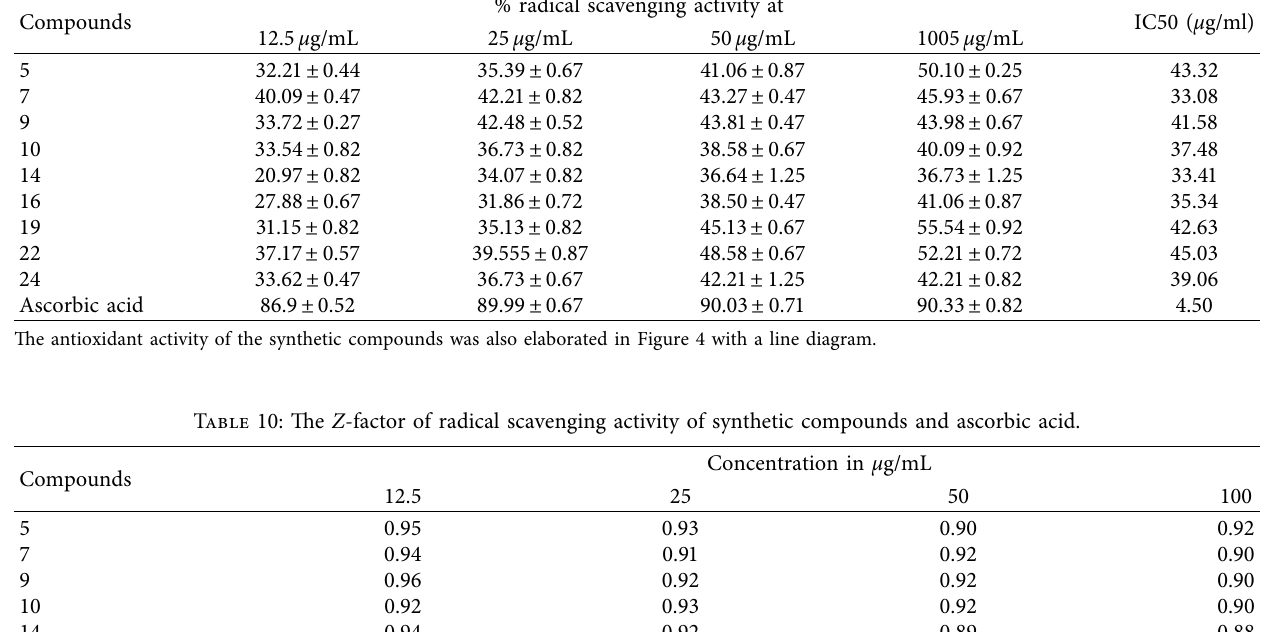
Table 9: Percent radical scavenging activity and IC50 values of synthetic compounds. Compounds